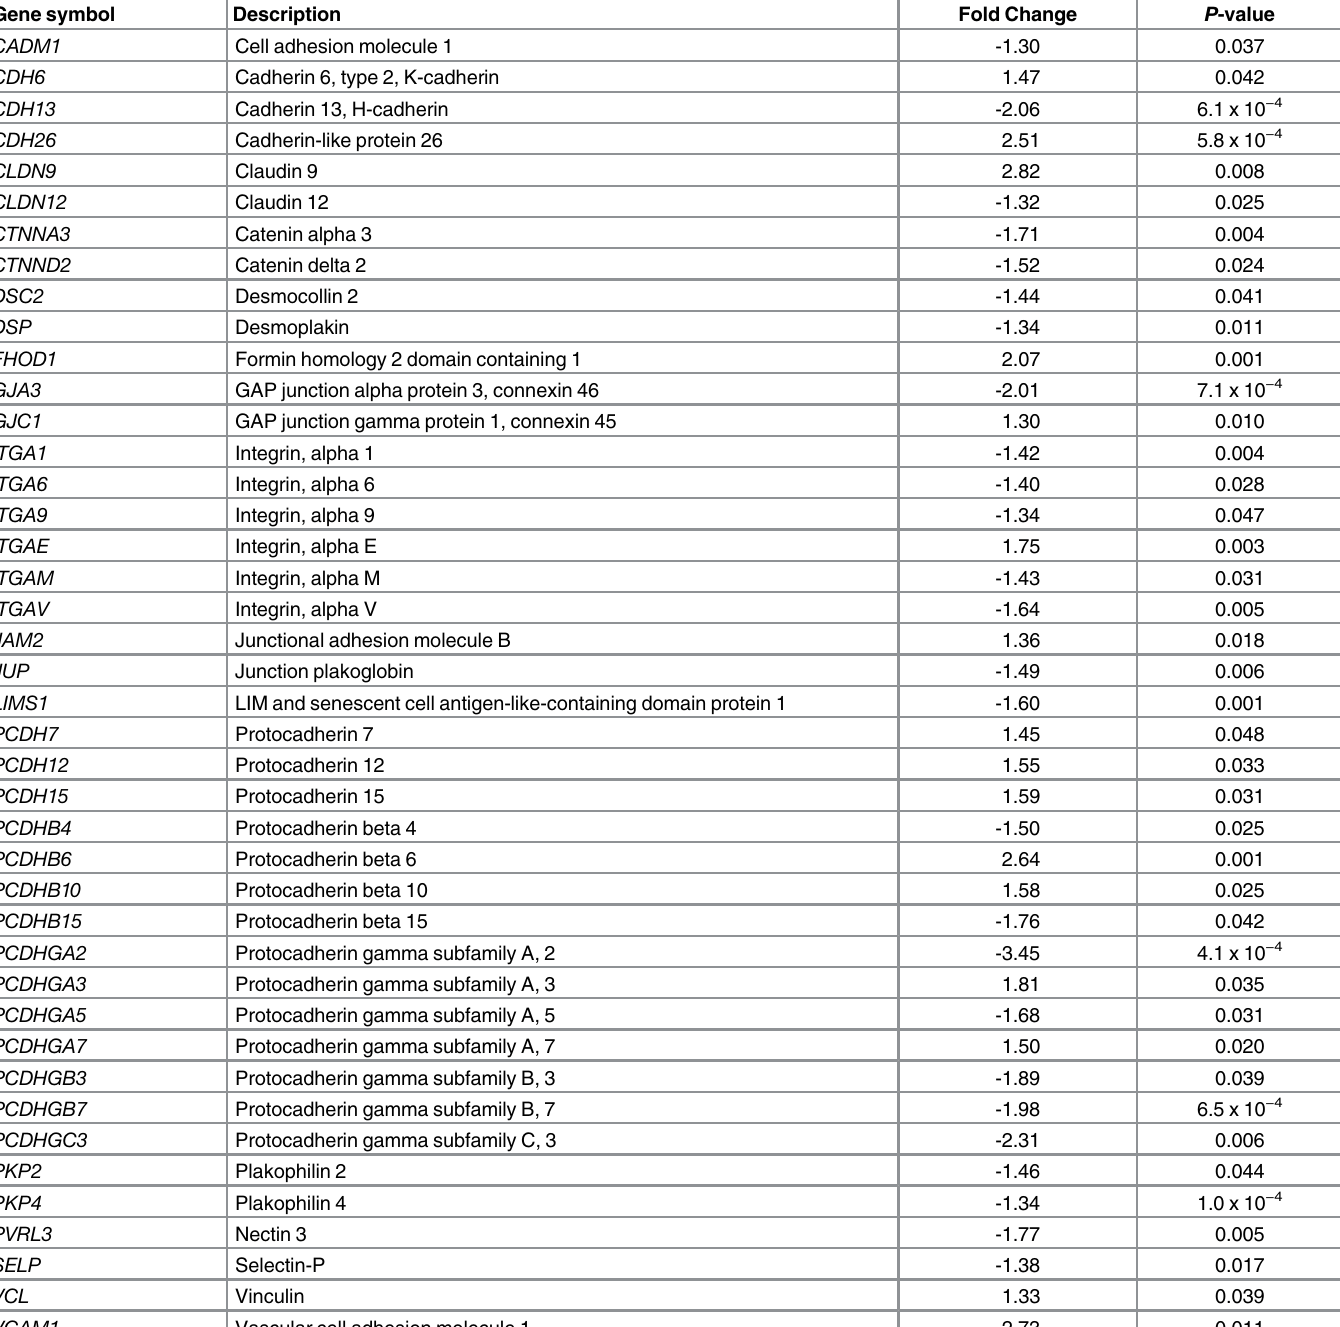
Table 2. Differentially expressed genes of adhesion molecules in ICM patients. Gene